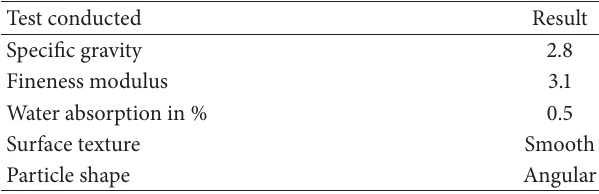
Table 2: Properties of fine aggregate.